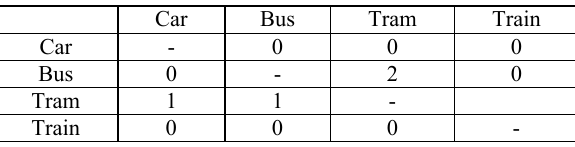
Table 4. Error matrix of SVMs